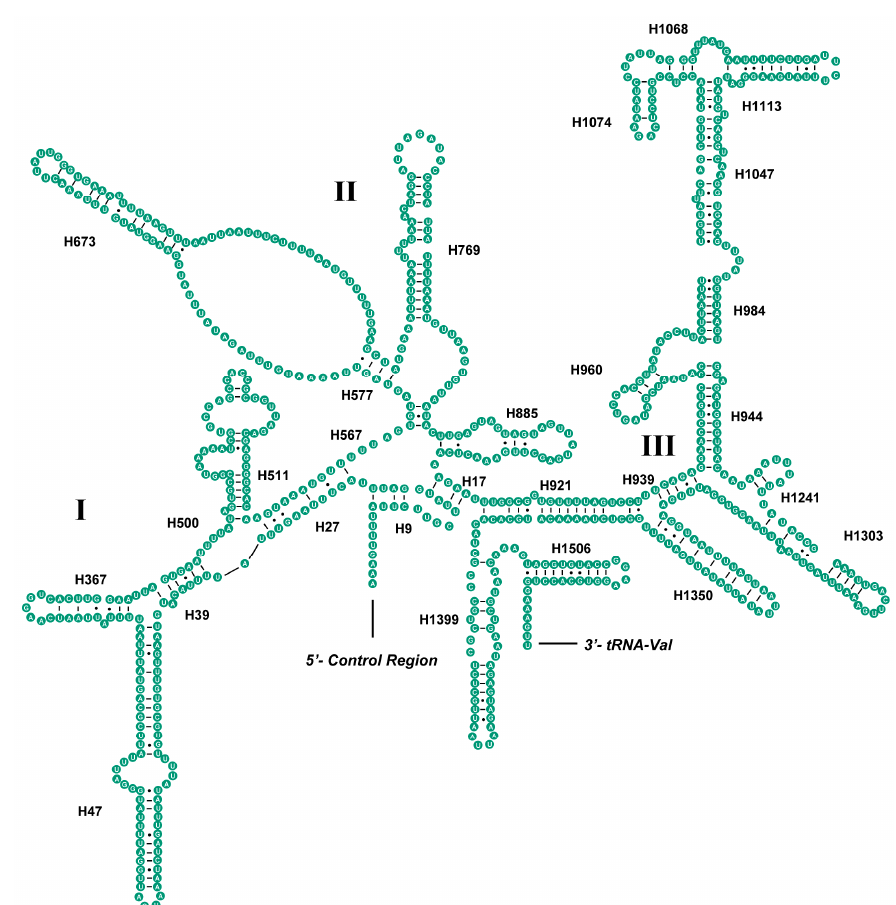
Figure 4. Predicted secondary structure of the srRNA gene in S. teleckojensis . Roman numerals denote the conserved domain structure. Dashes ( − ) indicate Watson-Crick base pairing and dots ( • ) indicate G–U base pairing. I–III indicate three domains in the secondary structure of srRNA .